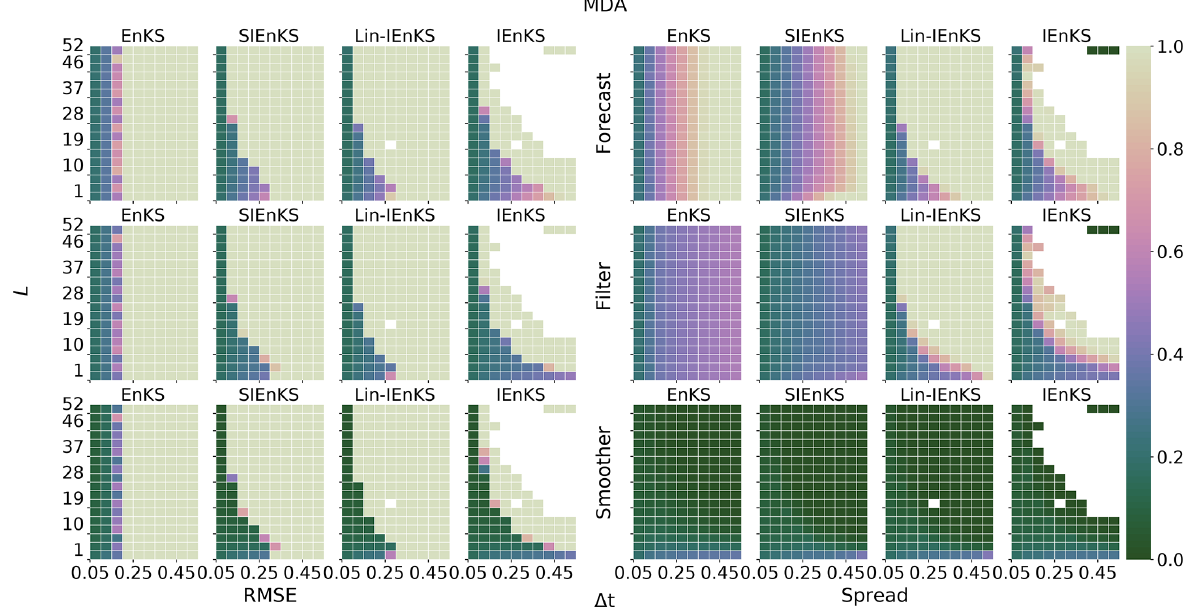
Figure 23. Lag length L on the vertical axis and (cid:49)t on the horizontal axis. MDA, tuned inflation, and ensemble size N e = 21 are